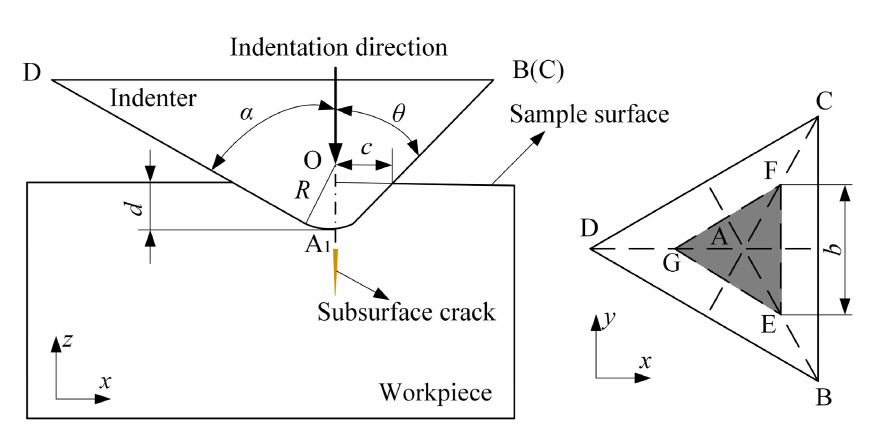
Figure 4. Indentation